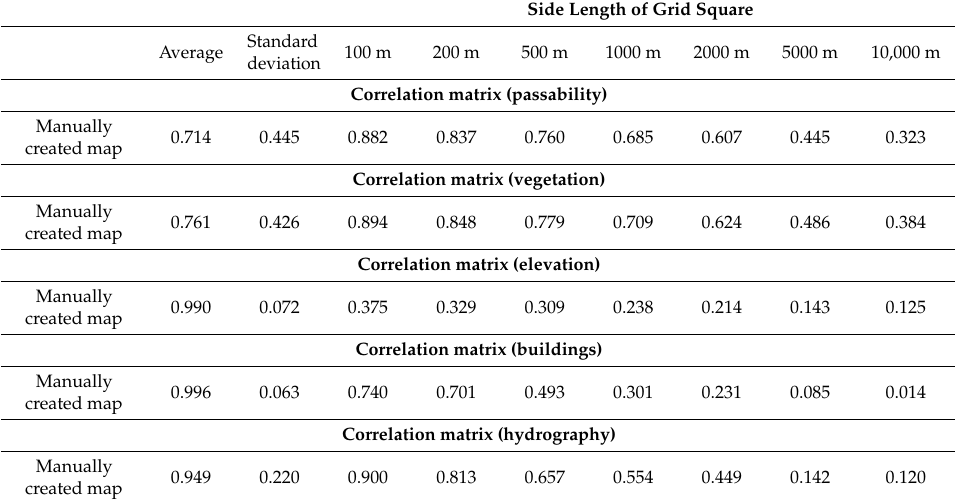
Table 12. Correlation matrices and basic statistic parameters for 1000 randomly selected control